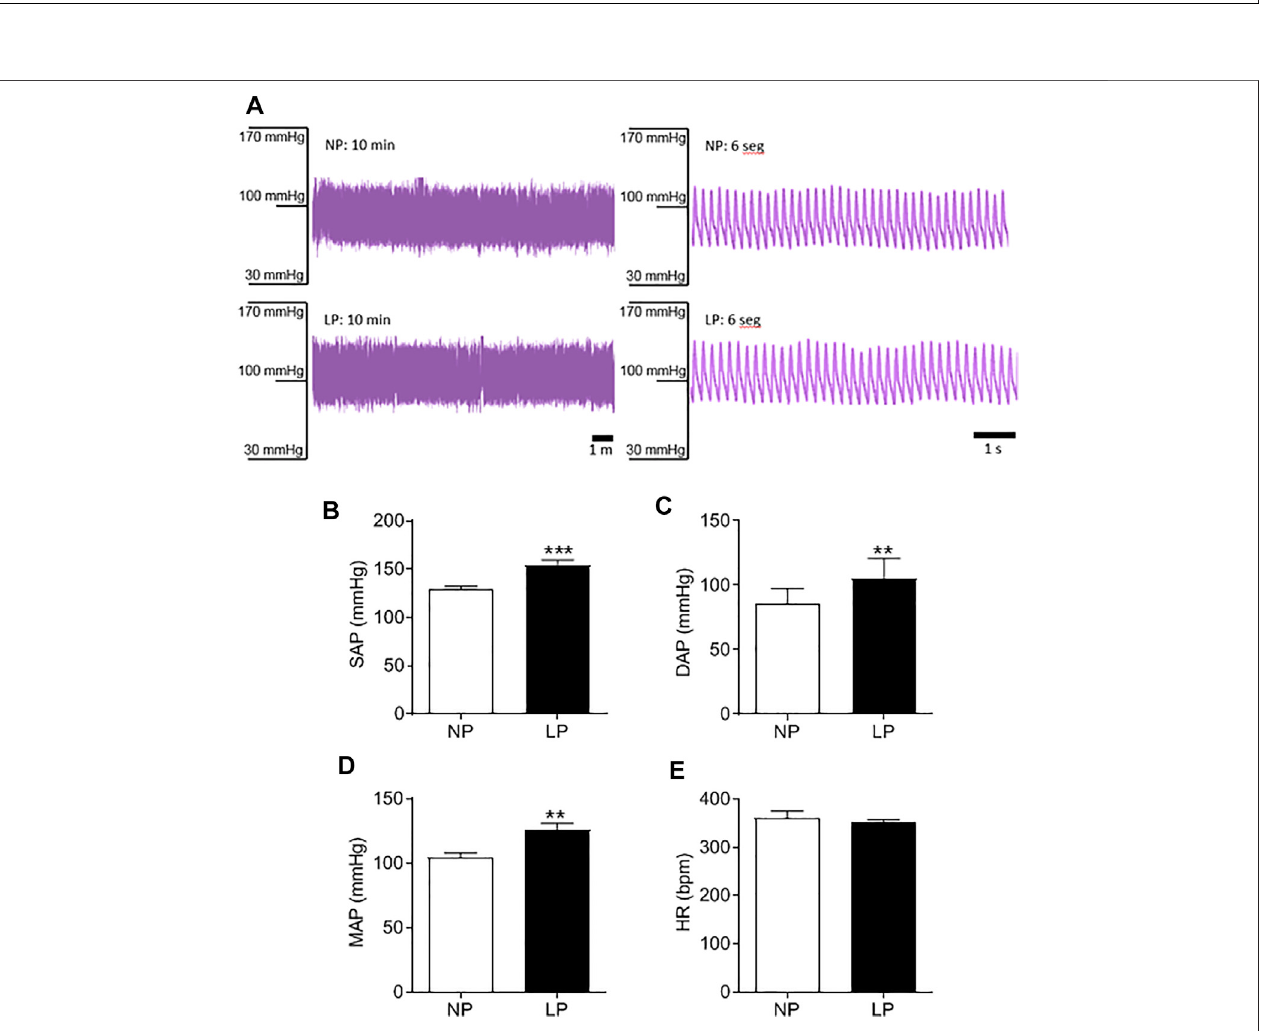
FIGURE 2 | Basal arterial pressure in 120 days old animal. Representative blood pressure traces of NP and LP animals in basal conditions (A) , Systolic arterial pressure (B) ,diastolicarterialpressure (C) ,meanarterialpressure (D) andheartrate (E) , n =9 – 10animalspergroup.NP,normalproteindiet;LP,lowproteindiet.Values presented as mean ± SD *** p < 0.001, ** p < 0.01, and * p < 0.05 indicate statistical signi fi cance (Student ’ s T test).